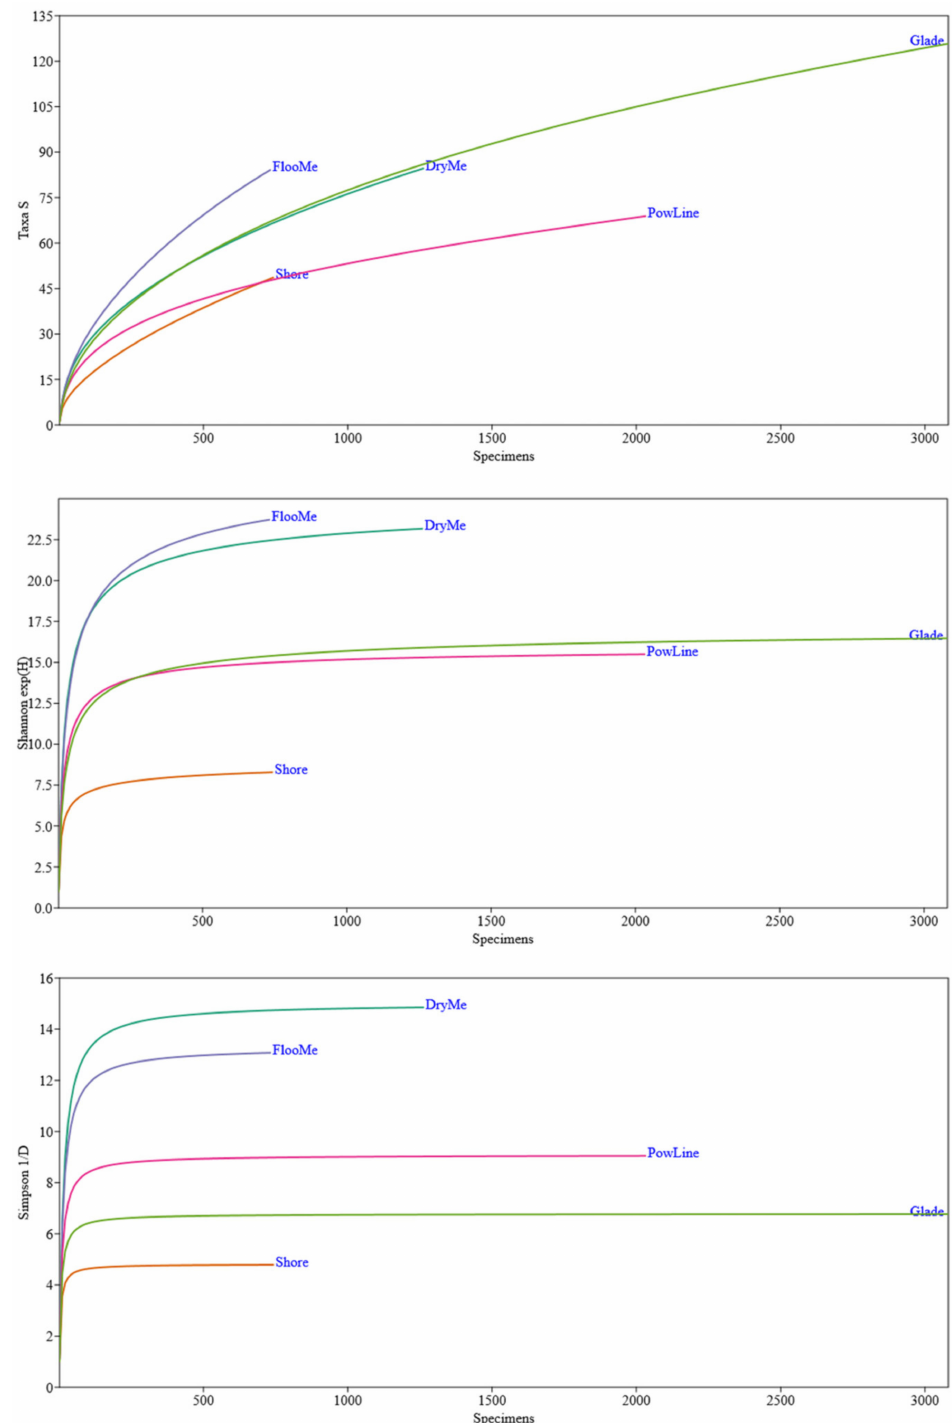
Figure 3. Differences in species richness (Taxs S) ( top ), exponential of Shannon entropy (exp(H)) ( middle ), and inverse Simpson index (1/D) ( bottom ) of beetles in five habitats. Designations: DryMe—dry meadows, Shore—shores, FlooMe—floodplain meadows, PowLine—cuttings under power lines, Glade—forest